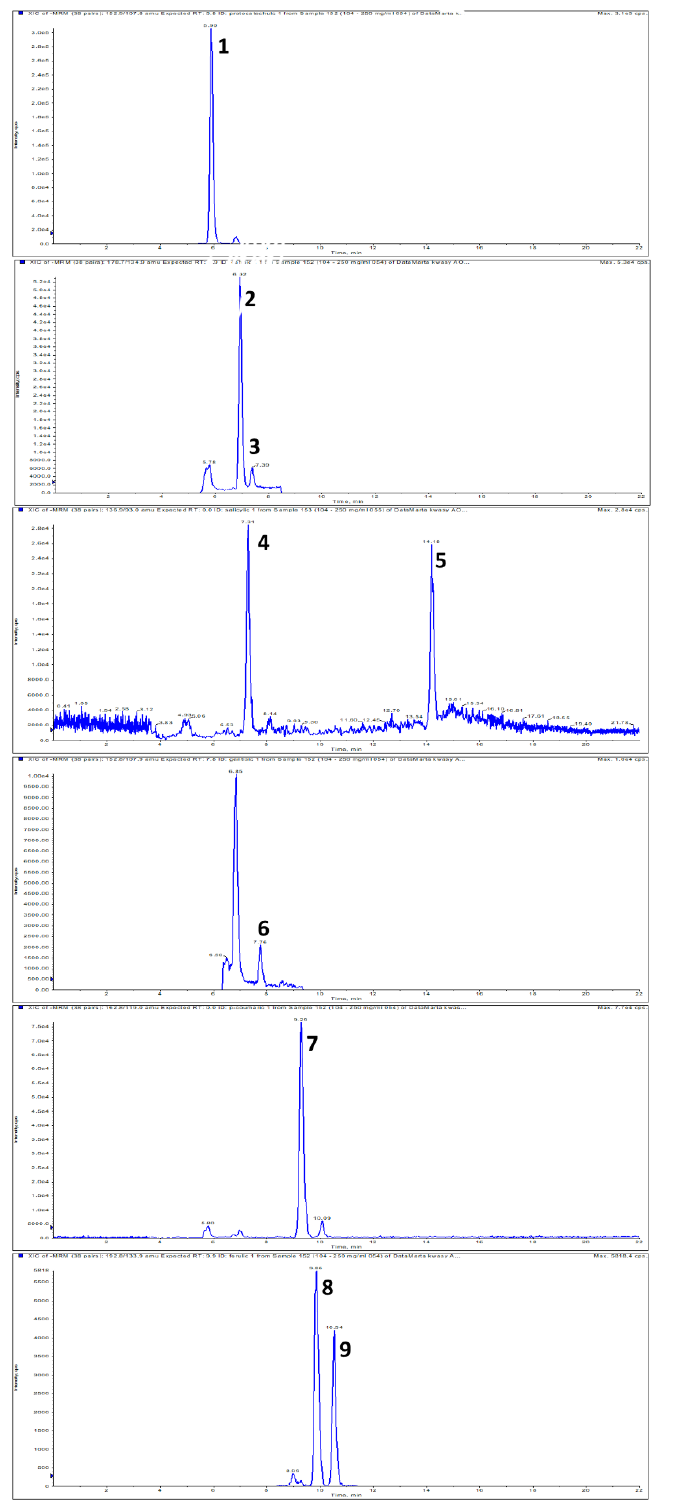
Figure 2: Extracted LC-MS-MRM chromatogram of phenolic acids found in sample with 20% addition of chokeberry fruit; MRM transition are given in brackets: 1 - protocatechuic (m/z 152.9 > 107.8); 2 – trans -caffeic (m/z 178.7 > 134.9); 3 – cis -caffeic (m/z 178.7 > 134.9); 4 - 4-hydroxy-benzoic (m/z 136.9 > 93); 5 - salicylic (m/z 136.9 > 93); 6 - gentisic (m/z 152.8 > 107.9); 7 - p -coumaric (m/z 162.8 > 119); 8 - ferulic (m/z 192.8 > 133.9); 9 - isoferulic acid (m/z m/z 192.8 >